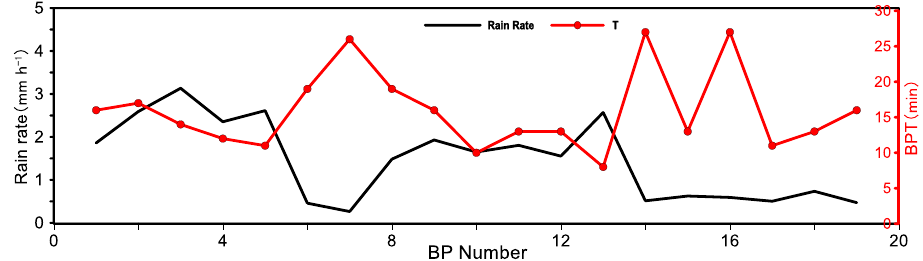
Figure 13. Time series of BPT (red line, unit: min), R (black line, unit: mm h − 1 ) and DSD parameters (lg ( N w ) (dark green line, unit: mm − 1 .m − 3 on log scale)), D m (light green line, unit: mm), µ (blue line) on 18 – 19 August 2021.